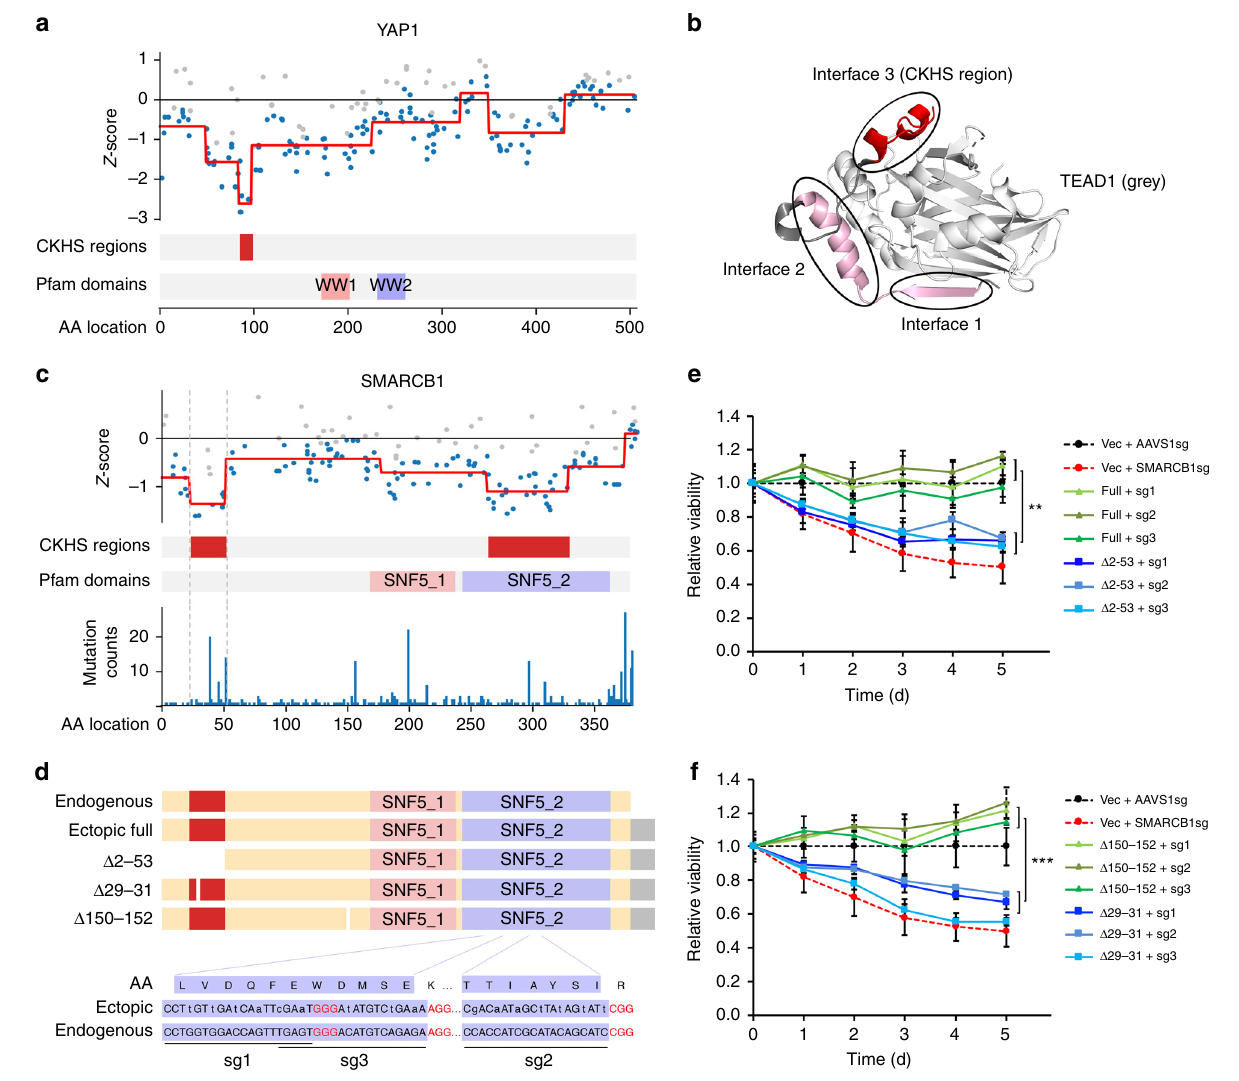
Fig. 2 CKHS pro fi ling facilitates the identi fi cation of unannotated essential domains. a The CKHS pro fi le and domain annotation of YAP1. b The 3D structure of the YAP1&TEAD1 interaction (PDBID: 3KYS). Three interfaces of YAP1 interact with TEAD1. The CKHS region (interface 3) is highlighted in red. c The CKHS pro fi le and domain annotation of SMARCB1, aligned with mutation frequency retrieved from the COSMIC database 47 . d A schematic representation of exogenous full-length, a truncated form ( Δ 2-53), and two small-deletion forms ( Δ 29-31, Δ 150-152) of SMARCB1, as well as the endogenous protein. The CKHS region is highlighted in red. The Myc and 6xHis tag sequences were appended to the C-terminus of exogenous proteins. Three sgRNAs were designed to target the endogenous SMARCB1 DNA sequence coding part of the SNF5_2 domain. Synonymous mutations were introduced into the exogenous proteins, except the bases at the PAM (red) and methionine codon. e Relative proliferation of DLD-1 cells with exogenous expression of full- length or the truncated form of SMARCB1 shown in d , in combination of endogenous SMARCB1 knockout. f Relative proliferation of DLD-1 cells with exogenous expression of SMARCB1 harboring small deletions inside or outside the CKHS region ( Δ 29-31 or Δ 150-152), in combination of endogenous SMARCB1 knockout. The red and black dash lines represent normalized relative viability of vector control cells with AAVS1sg or SMARCB1sg, respectively. All the data points represent the relative viability normalized to the AAVS1 control group. The error bars represent the standard divation of three biological replicates performed at each time point. The star symbols represent statistical signi fi cance: p < 0.01 (**) and p < 0.001 (***). The p -values were computed using t -test. Source data are provided as a Source Data fi